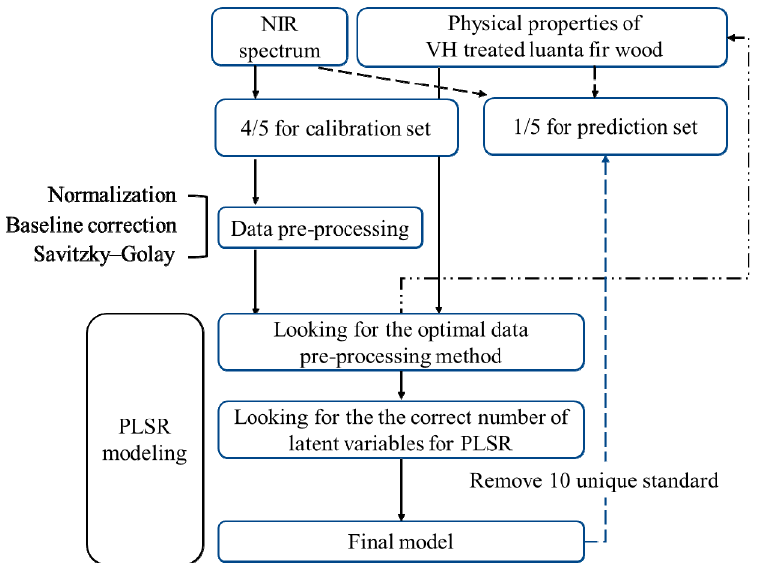
Figure 1. Schematic diagram of a prediction model for wood physical properties based on NIRS.